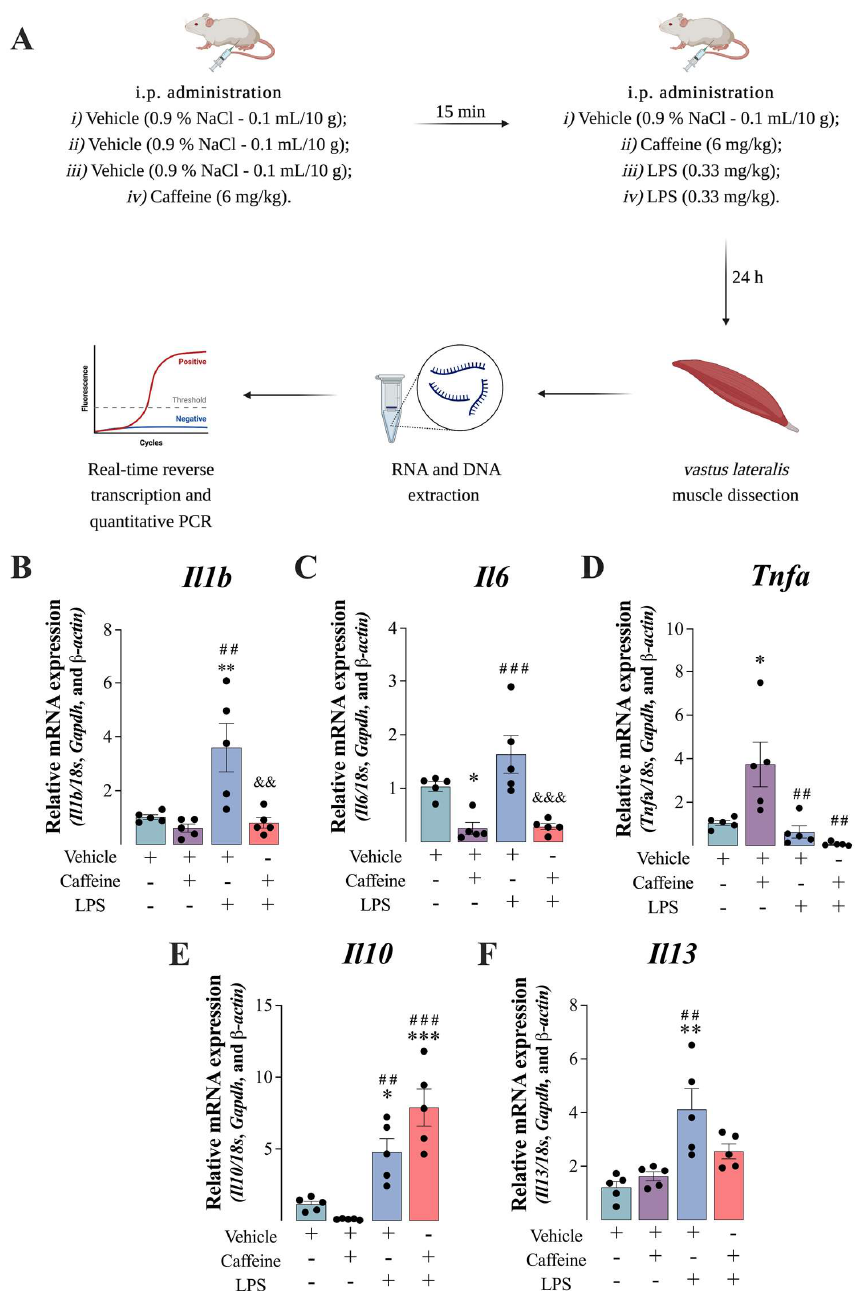
Figure 1. Caffeine administration reduced lipopolysaccharide (LPS)-mediated inflammation in the mouse vastus lateralis muscle. Adult Swiss male mice (3–5 months of age; body mass 45–50 g) received a single intraperitoneal (i.p.) injection of caffeine and/or LPS (See Materials and Methods for details). Schematic representation of the experimental protocol used to induced LPS-mediated inflammation in mouse, the muscle dissection and RNA/DNA extraction for the PCR analysis ( A ). The transcriptional profile of the cytokines Il1b ( B ), Il 6 ( C ), Tnfa ( D ), Il10 ( E ) and Il13 ( F ) were evaluated by qPCR after the total RNA extraction (TRIzol ® /Chloroform/Isopropanol method) from the muscle. Gene expression raw data were normalized by the average of the Ct of the 18s , Gapdh and β -actin genes and calculated by the method (2 −ΔCt ). Bars represent the mean ± standard error of mean of five independent experiments (animals) performed in technical duplicates. * p < 0.05; ** p < 0.01; and *** p < 0.001 vs. vehicle; ## p < 0.01; ### p < 0.001 vs. to caffeine, and && p < 0.01 and &&& p < 0.001 vs. LPS. Two-way ANOVA followed by Tukey’s